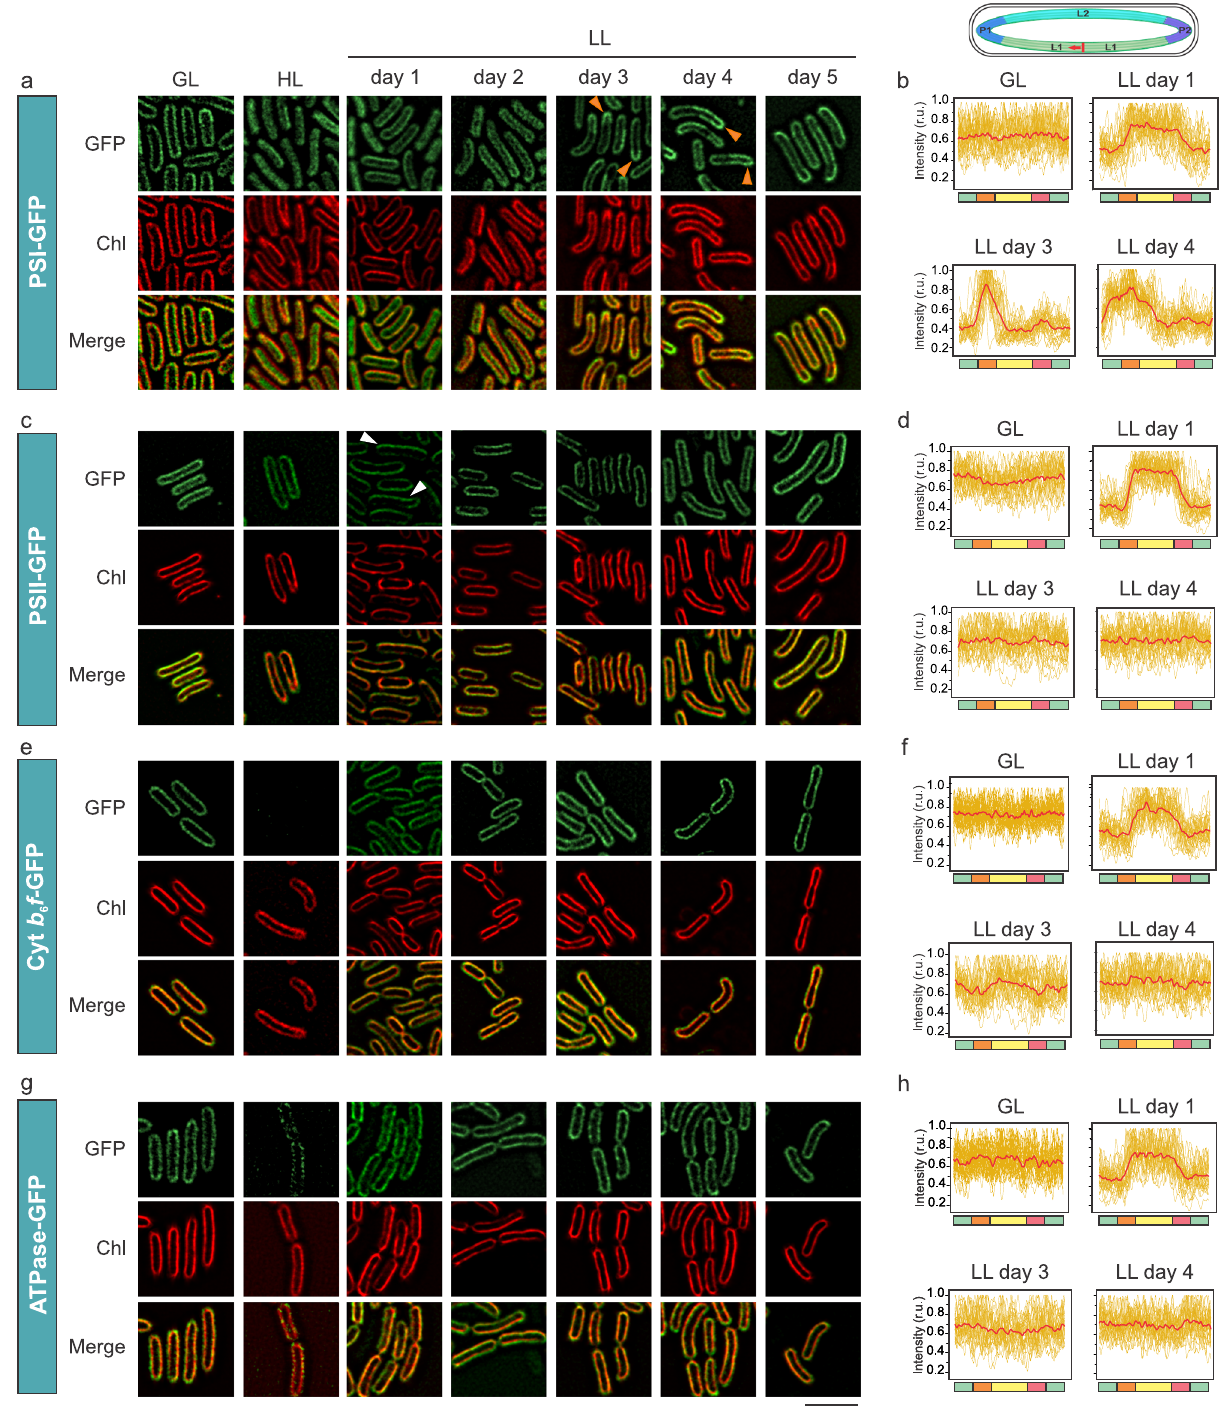
Fig. 5 Expression and intracellular localization of photosynthetic complexes in vivo in Synechococcus during thylakoid membrane biogenesis. a PSI: eGFP; c PSII:eGFP; e Cyt b 6 f :eGFP; and g ATPase:eGFP Synechococcus cells imaged by Dragon fl y spinning disk confocal microscope with the super- resolution radial fl uctuations (SRRF)-stream technology. Figures are representative of three biologically independent experiments. First row: GFP emission, second row: Chl fl uorescence, third row: merge. b , d , f , h GFP pro fi le analysis of PSI-, PSII-, Cyt b 6 f - and ATPase-eGFP around the cell in these strains. Pro fi les in red are the averages from 30 individual imaged cells, shown in yellow on the background, from three biologically independent experiments. In the schematic model shown on the top, L1 in green: longitudinal cell side 1, P1 in orange: pole 1, L2 in yellow longitudinal cell side 2, P2 in pink: pole 2. In each cell tracking of eGFP-signal was started from the same site (indicated by the red vertical line) and to the same direction (indicated by red arrow). A higher difference between the minimum and maximum of the signal indicates the more clustered distribution of proteins. Cells were grown under growth light (GL), high light (HL), and HL-grown cells were then transferred to low light (LL) conditions for fi ve consecutive